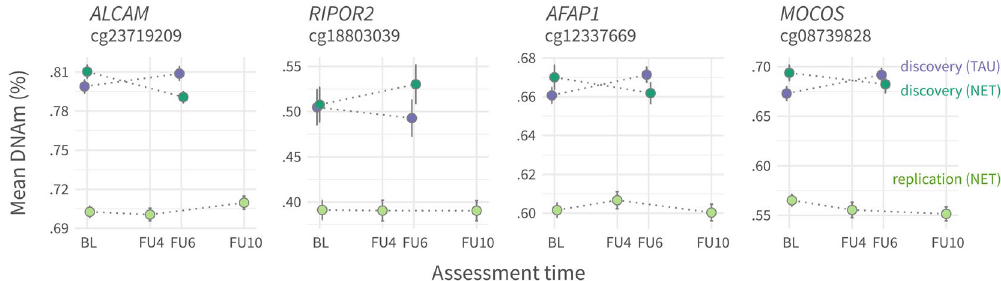
Figure 2. Significant associations between treatment condition and DNAm change. Mean DNAm (%) as a function of assessment time at discovery and replication sample (colour coded) for the four CpGs that significantly had an association between treatment effect and DNAm. Dots represent group means and bars show standard errors. Note that samples had different follow-up assessment times (FU4,6,10; numbers represent months) after baseline (BL). Replication sample does not support findings statistically in discovery